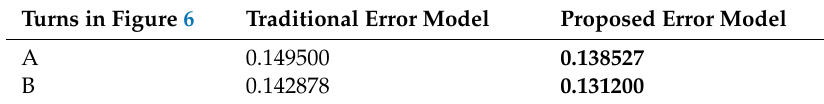
Table 1. Average RPE results at A and B turns of traditional error model and our proposed error model. The numbers in bold indicate that these terms are better than those of another model. The unit of RPE is